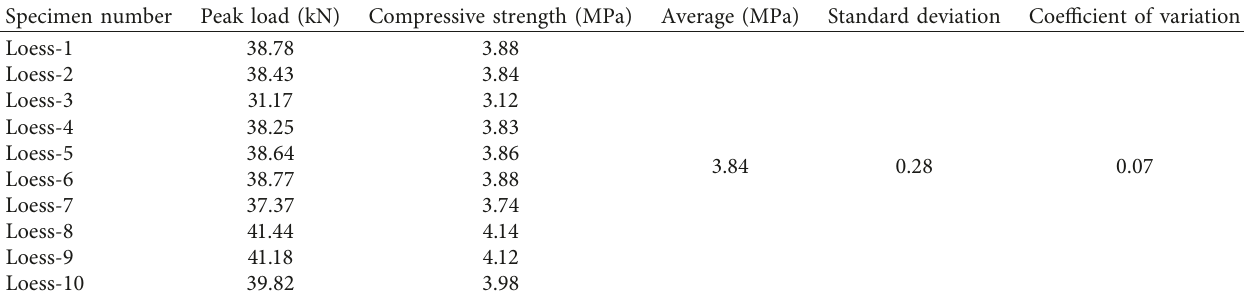
Table 2: Results from loess cubes.